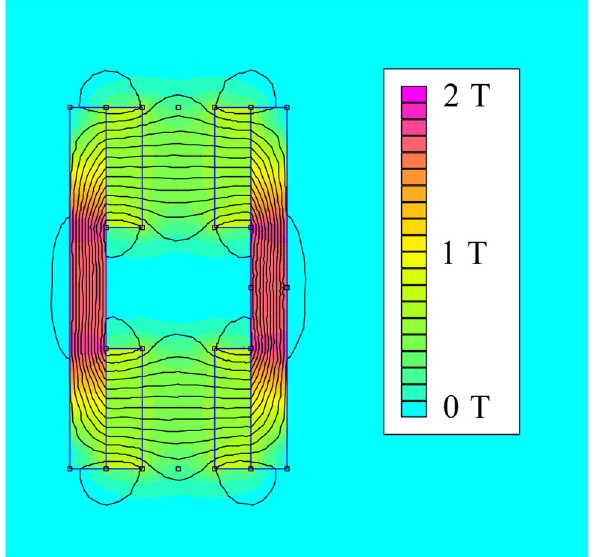
Figure 4. Planar FEMM model of magnetic circuit; analysis of magnetic flux density B